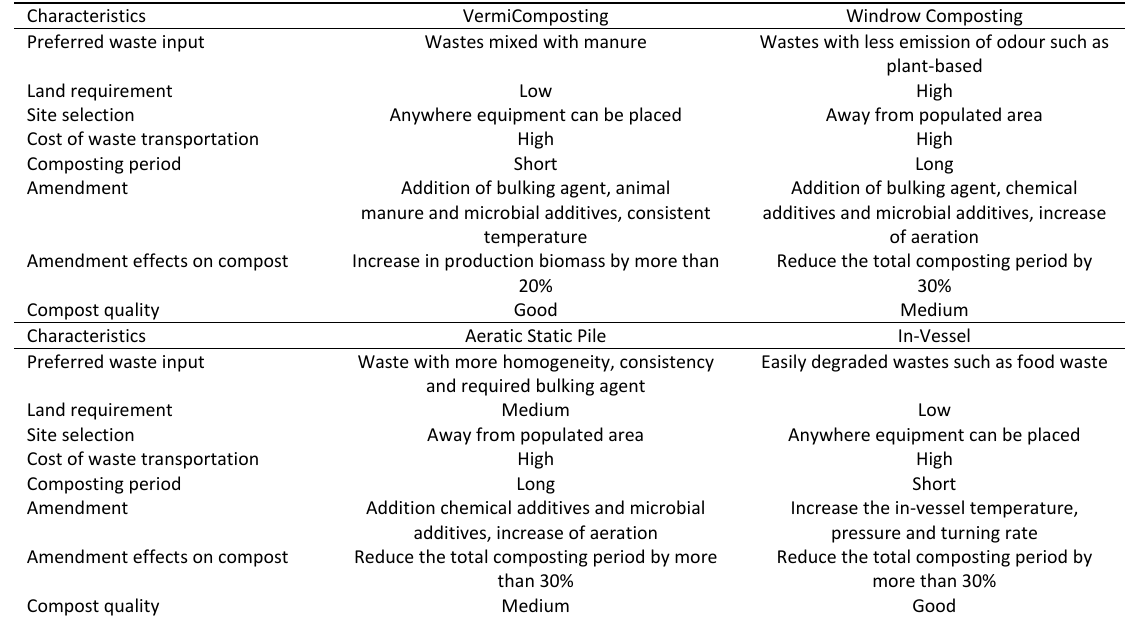
Table 2: Characteristics of Composting Techniques